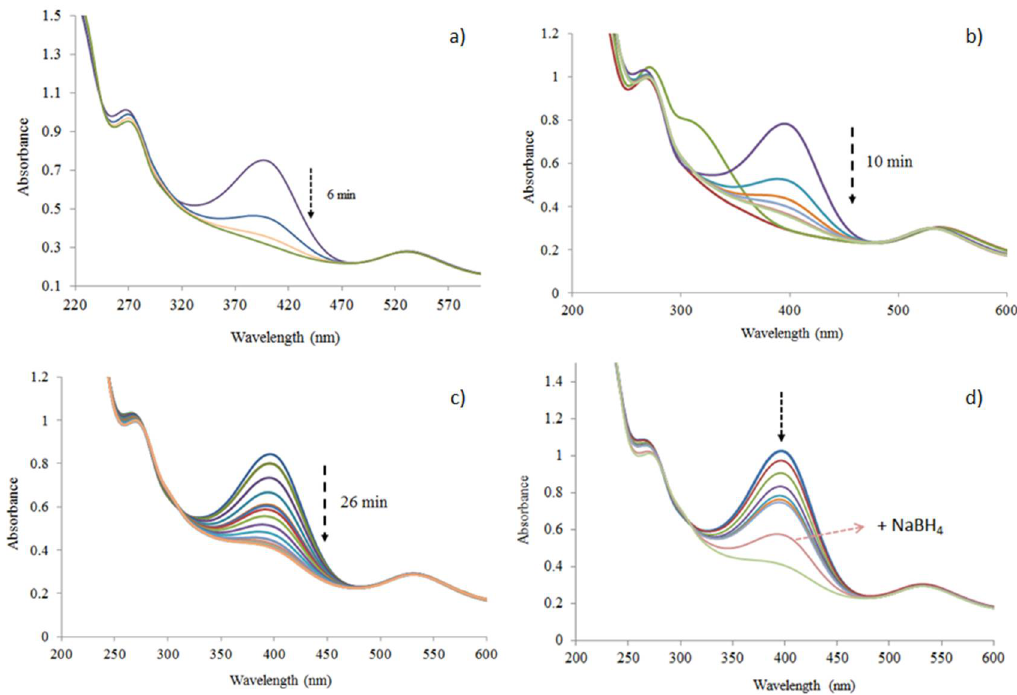
Figure 10. Reutilization of AuNPs 1% tea as the catalyst in the reduction of 4-NP. ( a ) First addition of 4-NP; ( b ) second addition of 4-NP; ( c ) third addition of 4-NP; ( d ) fourth addition of 4-NP and subsequent addition of NaBH 4 . All additions were in identical conditions to those of entry 5, Table 1.